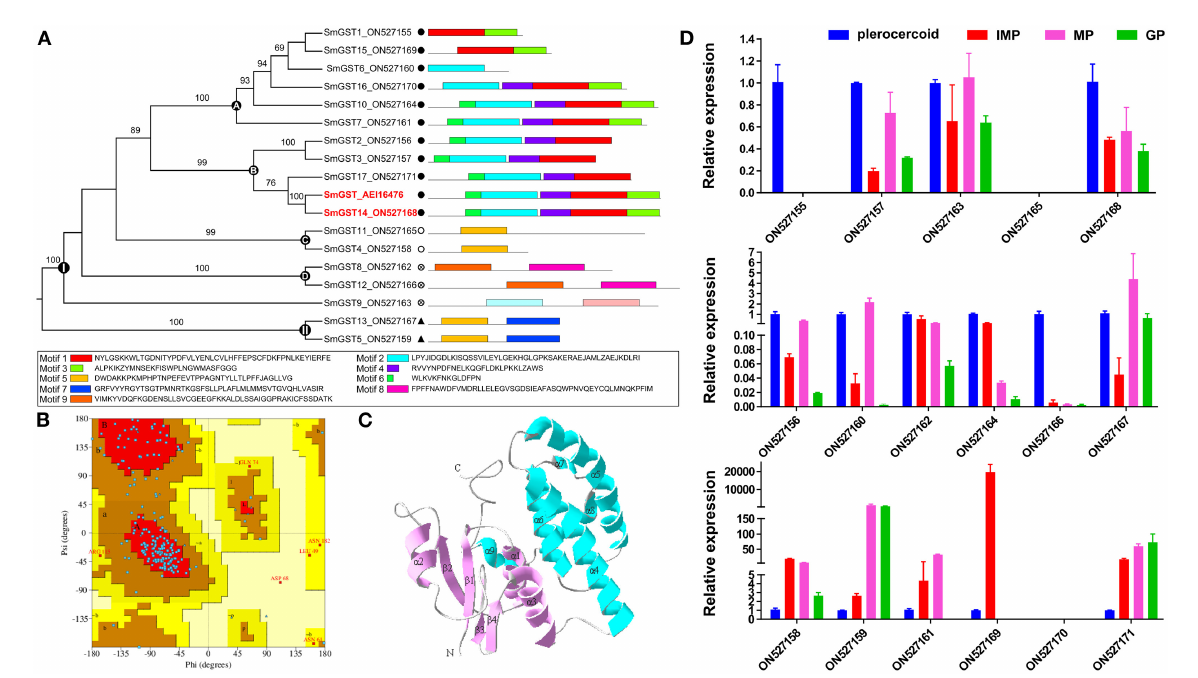
FIGURE1 Glutathione transferase protein family members identified in Spirometra mansoni . (A) Phylogenetic tree and conserved motifs of SmGSTs. The symbol “ N ” indicates microsomal GSTs (MAPEG), “ • ” indicates Mu class cGST, “ ◦ ” indicates Sigma class cGST, “ ⊗ ” indicates unknown class cGST. (B) Model quality evaluation of 3D structure of SmGST. Red represents the most favored regions, brown indicates additional allowed regions, yellow indicates the generously allowed regions, light color indicates disallowed regions. (C) Ribbon protein structures of SmGST. Swiss-model protein modeling server was used for modeling; α -helices show as ribbons and β -strands as arrows. Pink: the thioredoxin-like domain (N-terminal GSH binding domain), Green: C-terminal substrate binding domain. (D) GST genes expression of S. mansoni in different tissues by qRT-PCR. The expression level was normalized to GAPDH and measured with 2 − 11 Ct value. Results are averaged from three independent replicates during all stages. Error bars represent SD ( n = 3). IMP, immature proglottide; MP, mature proglottide; GP, gravid